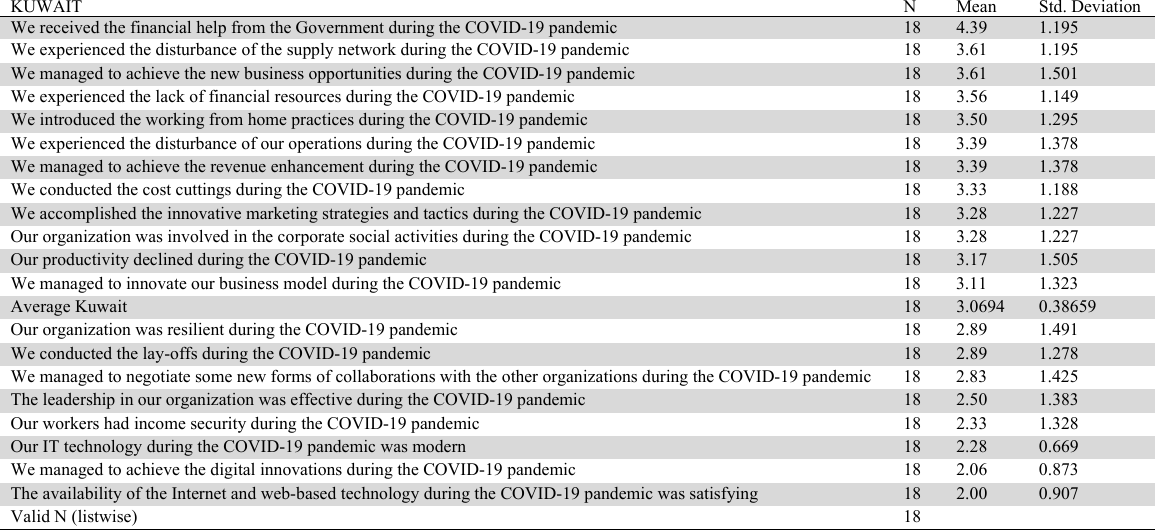
The results of the impact of COVID-19 in Kuwait, with variables in descending order KUWAIT N Mean Std. Deviation We received the financial help from the Government during the COVID-19 pandemic